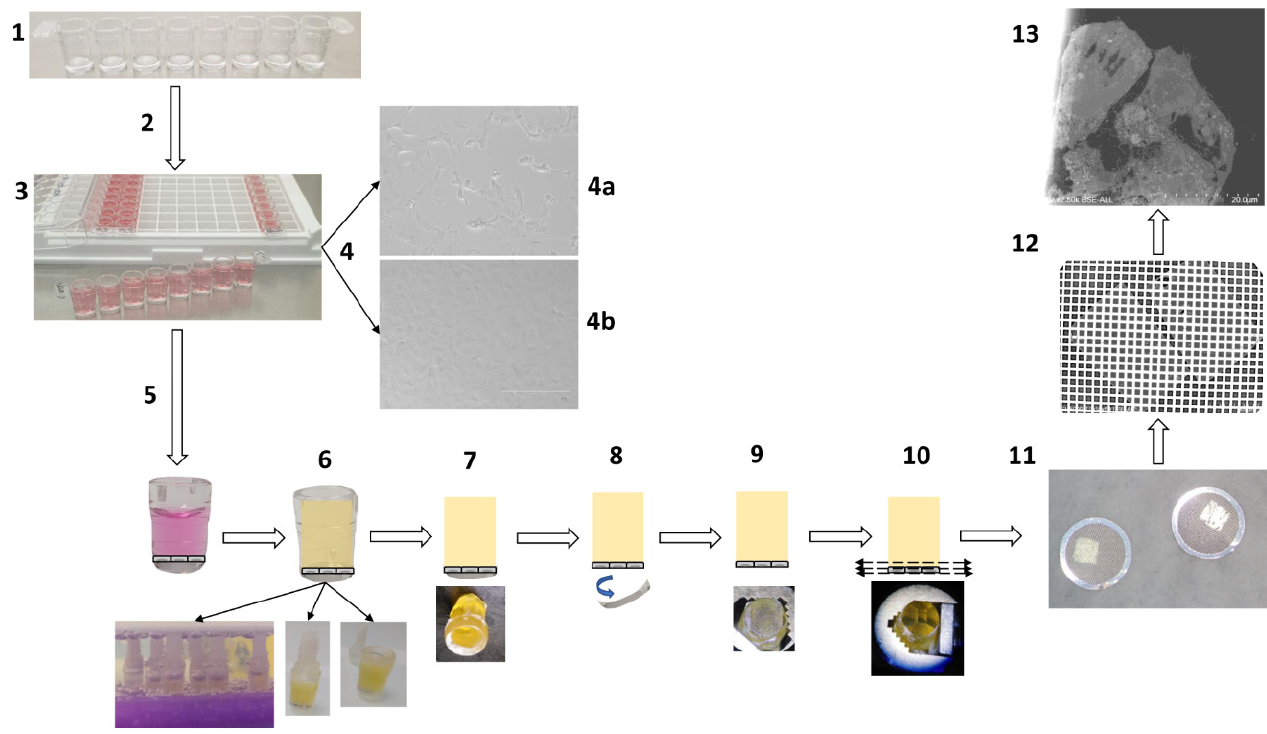
Figure 1. Schematic representation of the methodology for fast electron microscopic examination of a virus culture. (1) Removable single-break strips are UV sterilized and collagen-coated. (2) Cell culture with 200 μ L suspensions of Vero E6 cells at 2 × 10 5 cells/mL per well. (3) Cells are virus-inoculated with 50 μ L of strains or clinical sample per well. (4) Cytopathic effect detection: cytopathic effect (4a) is monitored by bright-field light microscopy, in comparison with a negative control (4b). (5) Cell fixation: cell monolayers are fixed with 2.5% final glutaraldehyde. (6) In-well resin embedding in 4 h: washes, dehydration, resin substitution and wells closed by cap sealing for microwave polymerization. (7) Plastic pruning: resin blocks are manually trimmed with a razor blade. (8) Detachment of the cell monolayer: the plastic bottom of the well is detached by cold shock via immersion in liquid nitrogen for 20 s. (9) Resin block: the resin block containing the cell monolayer at one side is ready for ultramicrotomy. (10) Ultramicrotomy: the resin block is trimmed to a pyramid and ultra-thin sections are obtained. (11) Positioning on grids: ultra-thin sections are deposited on copper/rhodium grids. (12) Contrast and metal deposition: sections are contrasted with uranyl acetate and lead citrate and grids attached to a glass slide are platinum sputter-coated. (13) Electron microscopy: electron micrographs are obtained by SEM.